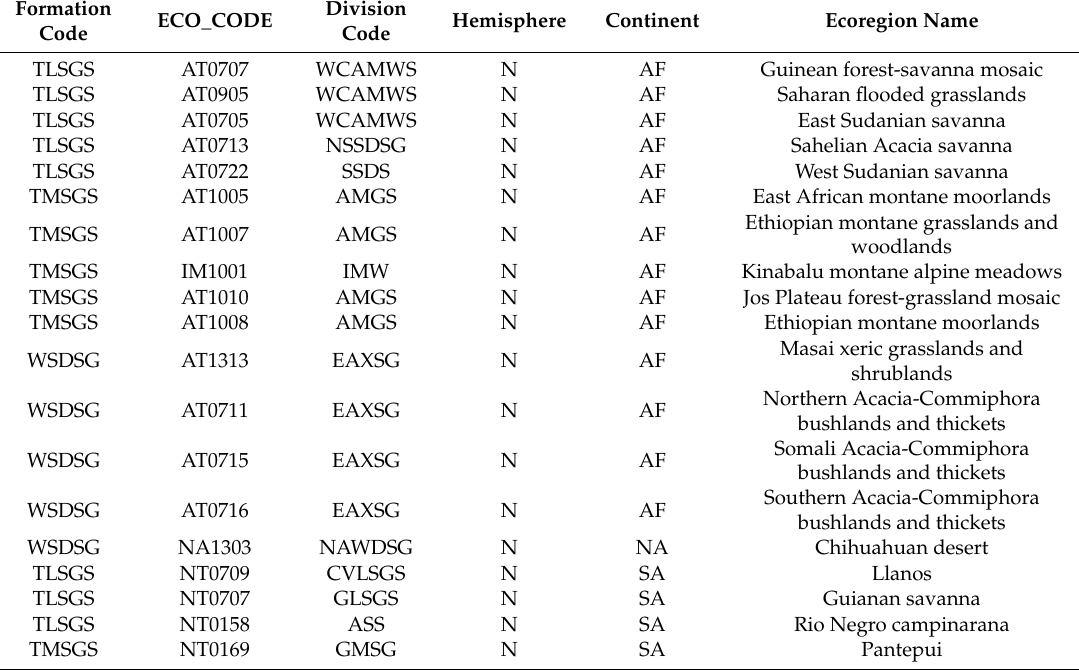
Table A3. Savanna, woodland and shrubland ecoregions with World Grassland Types (Dixon et al., 2014). (See Table A2 for description of Formations and Divisions; Continent codes as follows: AF—Africa; NA—North America; SA—South America; AU—Australasia (includes New Guinea and New Zealand)). Formation